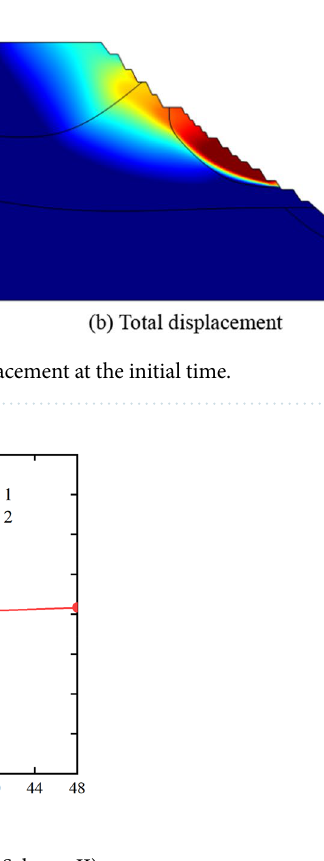
Figure 24. Slope safety factor with time (Scheme I and Scheme II).